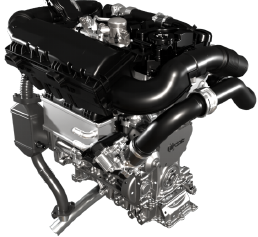
Figure 4. Prototype